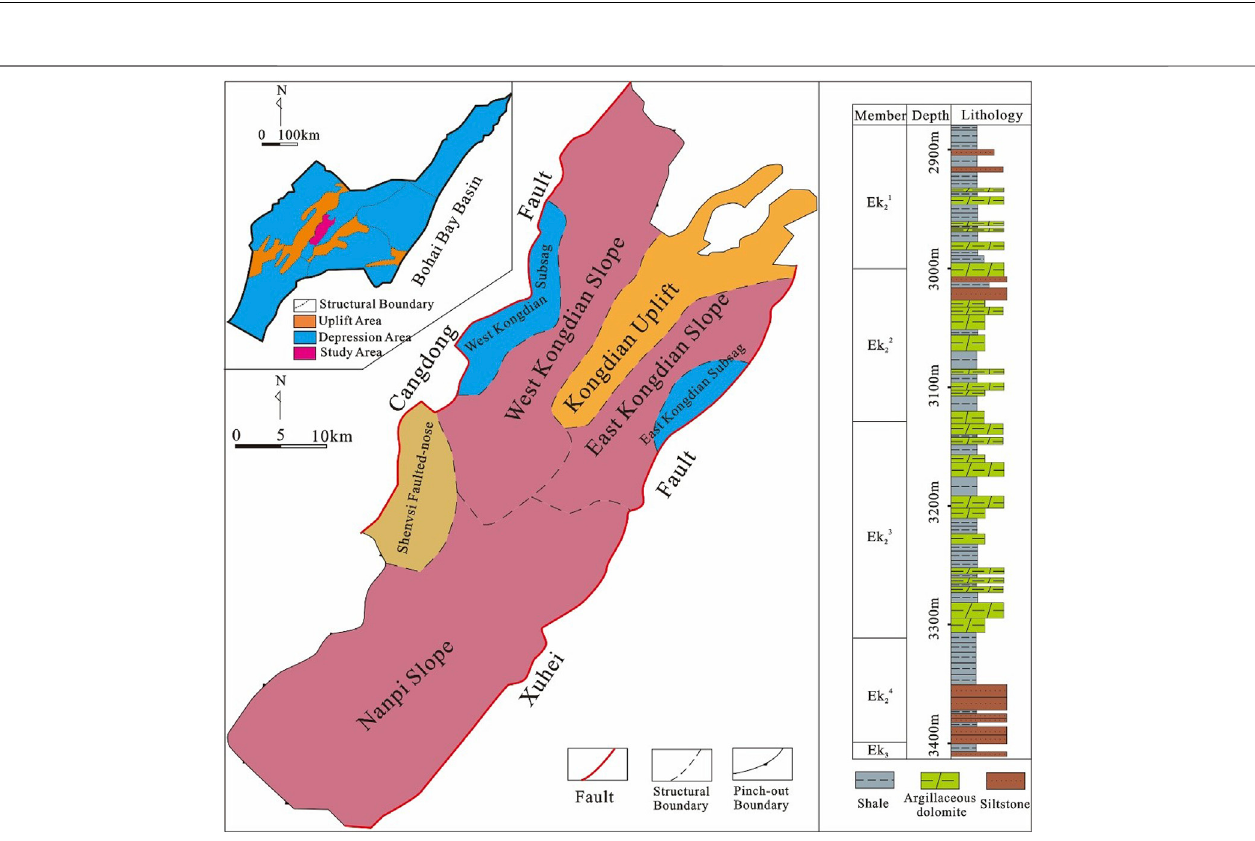
FIGURE 3 | Map of the Cangdong Sag and lithology column of the second member of Kongdian Formation (Modi fi ed based on Zhao et al., 2018).